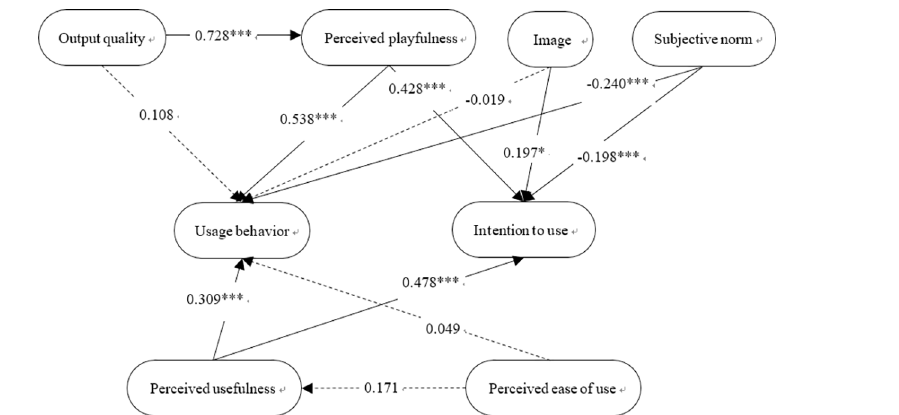
Fig 6. Path analysis model for research hypotheses pertaining to physical exergames.